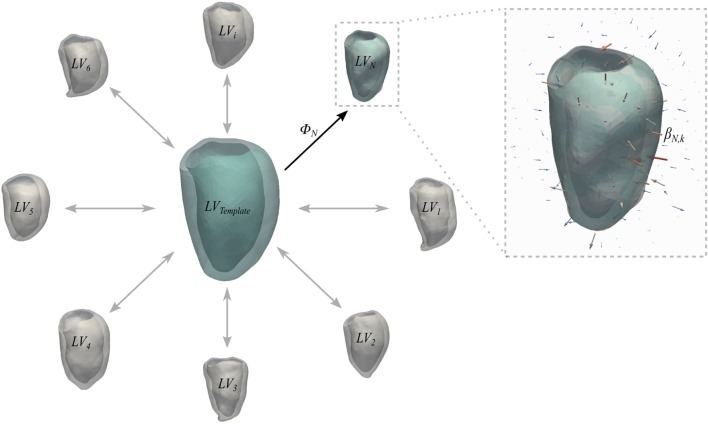
Schematic representation of the concept of anatomical model. Template and deformations ϕi toward each shape are estimated with an alternate registration algorithm. The template is initialized as the mean shape and the deformations ϕi are estimated using a Large Deformation Diffeomorphic Mappings framework (23, 24). Each deformation ϕi is defined by a set of momenta vectors βik (arrows in the magnified panel) located at the control points grid.